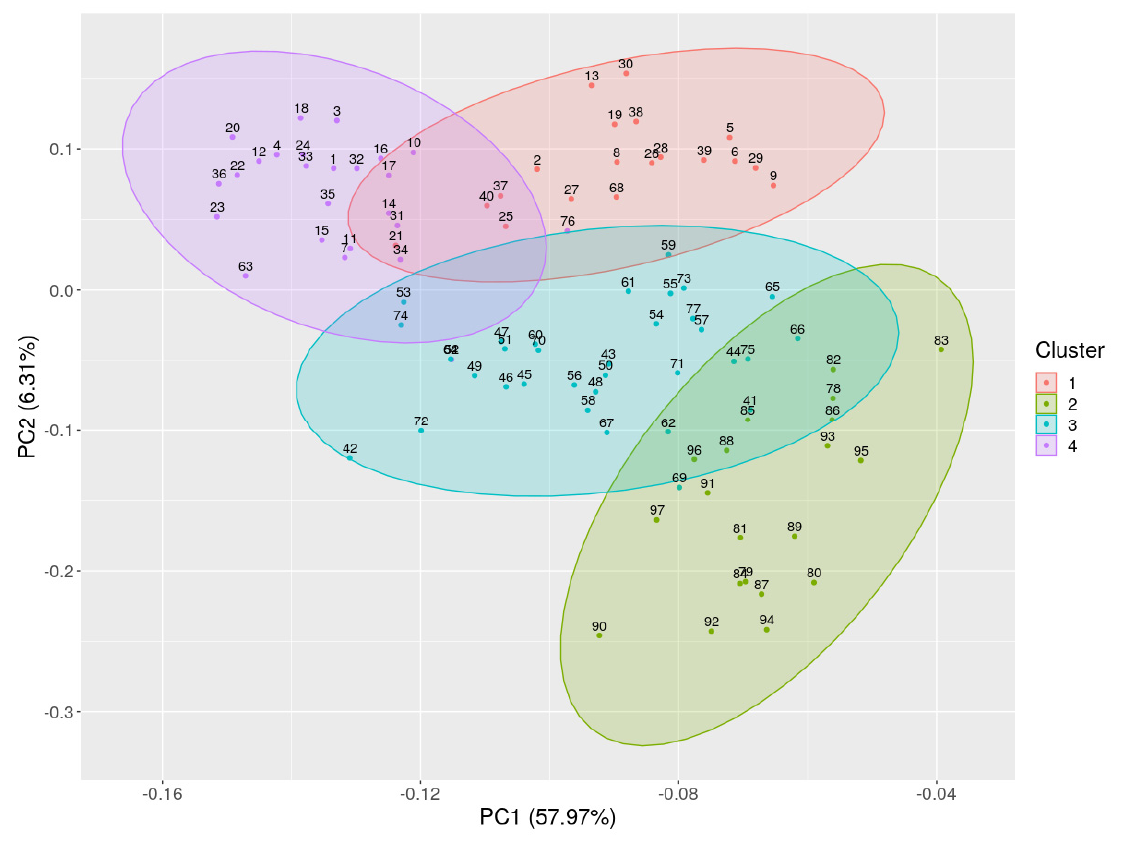
Figure 2. Visualization of PCA analyses.